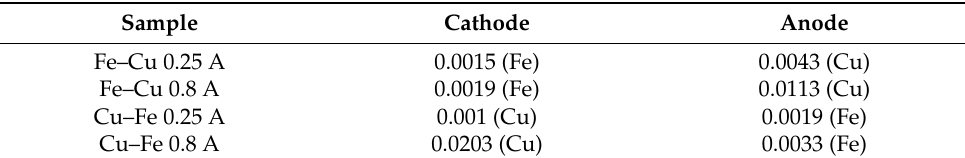
Table 1. Mass change of electrodes.